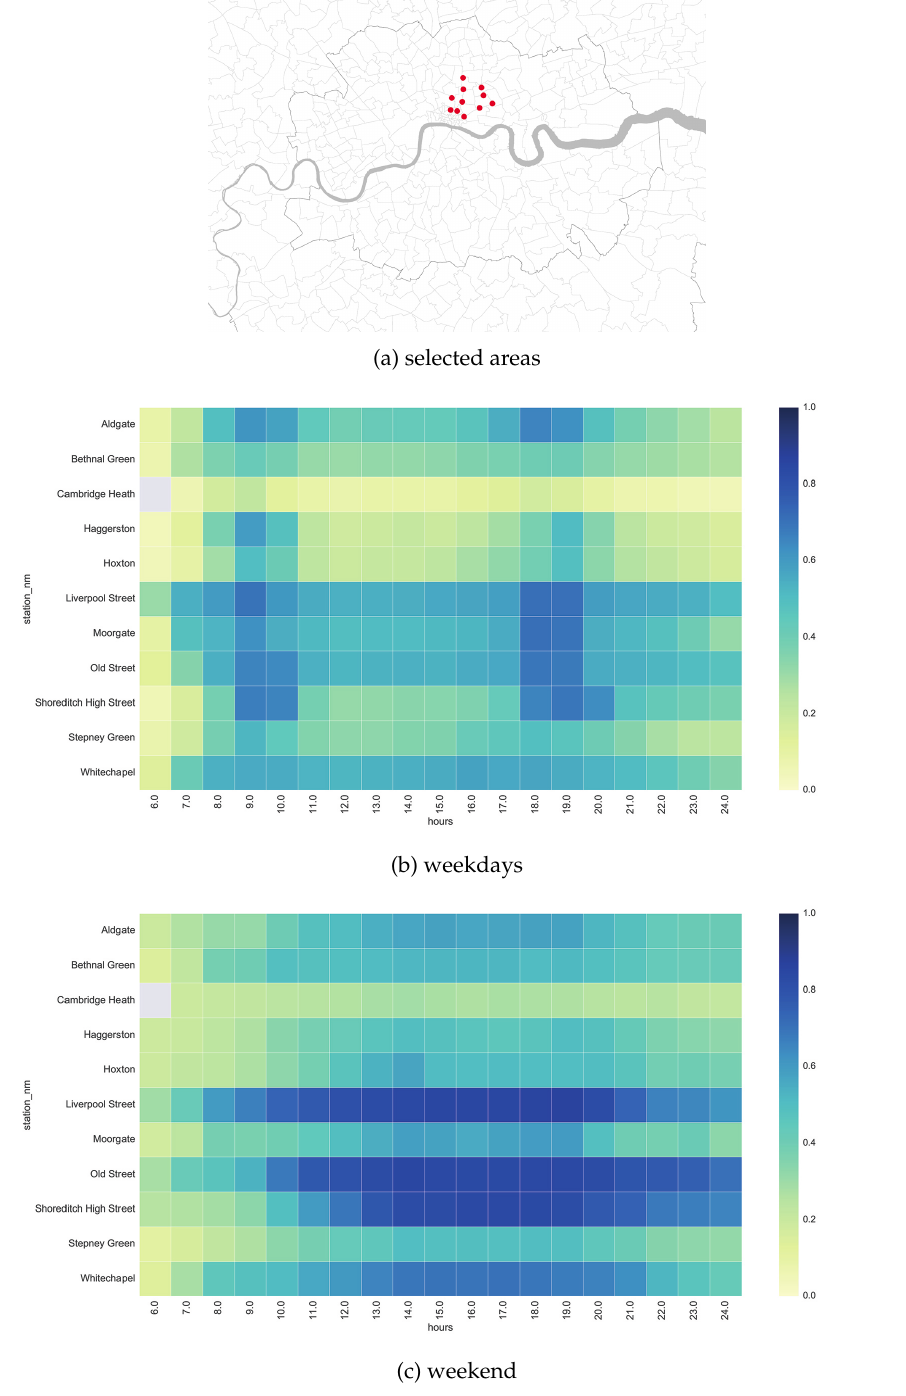
Figure 8: Hourly variation of vitality in East